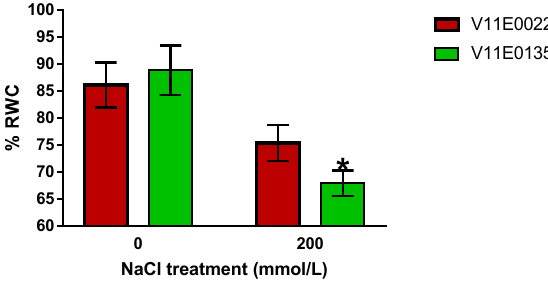
Figure 2. Relative water content (RWC) of water dropwort cultivars under salt stress. Bars with the asterisks (*) indicate the significant difference ( p < 0.05) between the control and its respective treated samples. Values are means ± SD.